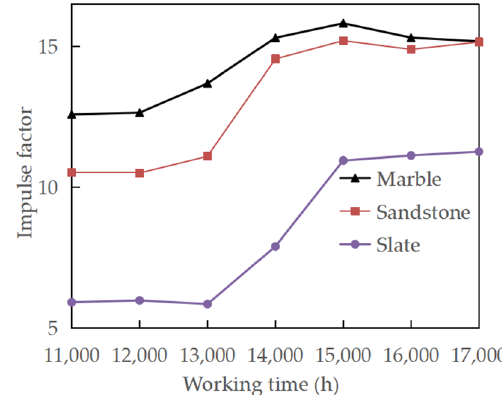
Figure 15. Curve of impulse factor with time.